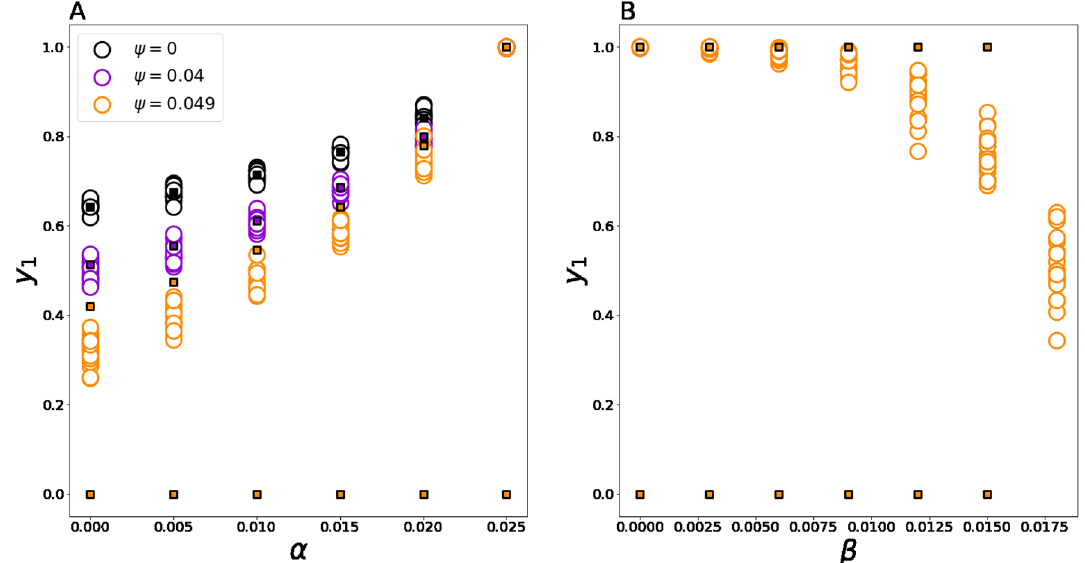
Figure 3. The panels compare mean-field predictions of the model behavior (colored squares) against simulations (white circles) in Scenarios 1 (panel A) and 2 (panels B). In the presented experiments, 2000 agents were considered for which opinions were initialized from the uniform distribution. Limiting opinion distributions were obtained after 1,000,000